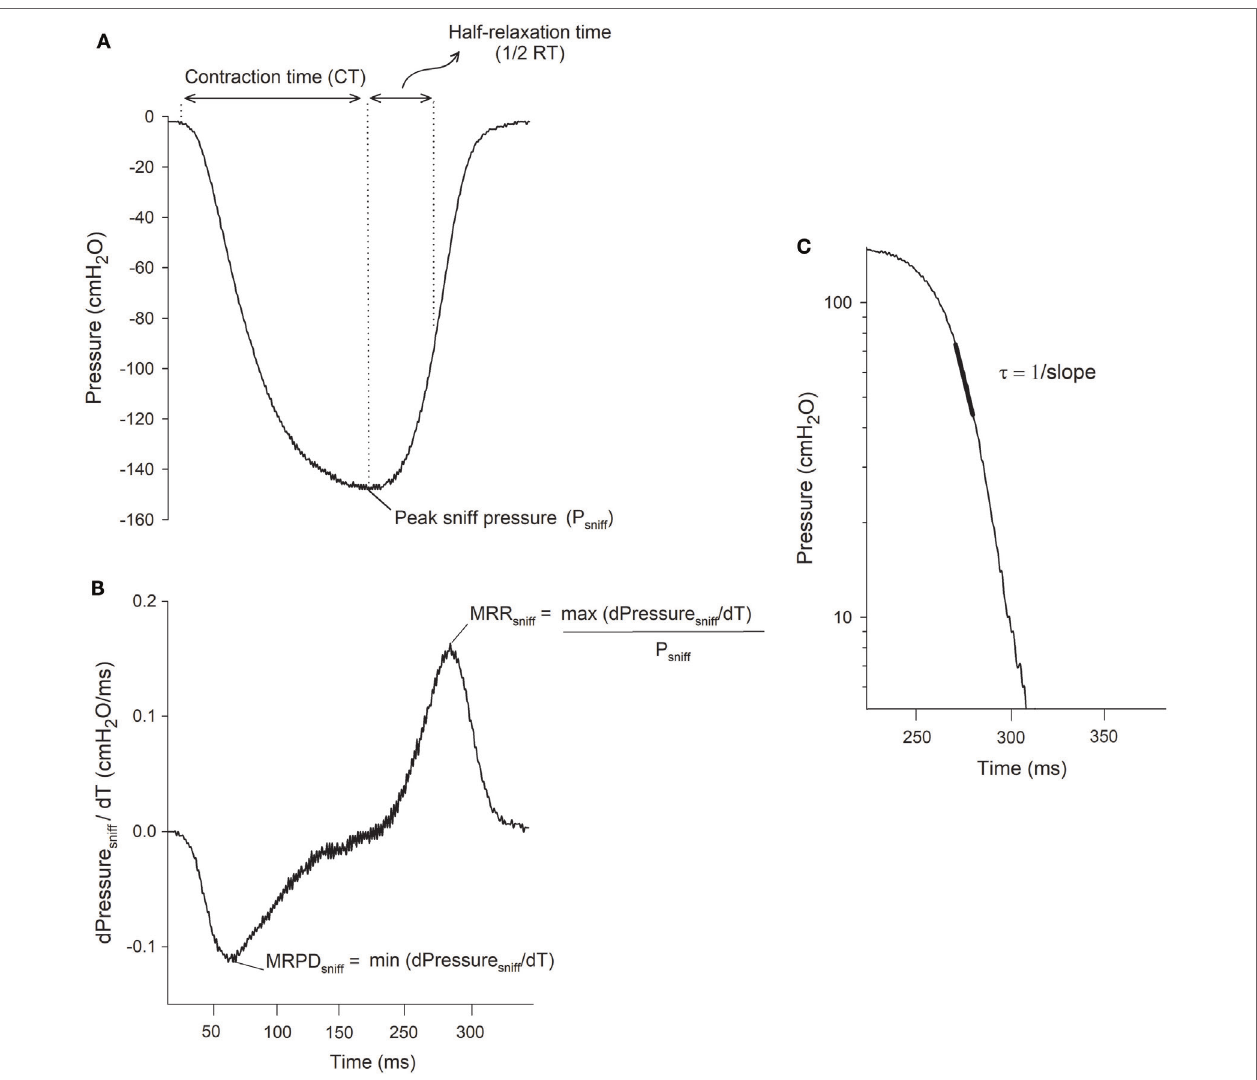
FigUre 1 | Representative tracings of the sniff nasal inspiratory pressure (SNIP) test and its parameters. (a) Tracings of SNIP change; peak sniff pressure (P sniff ); time to reach P sniff , contraction time (CT); and half-time of the relaxation curve (1/2RT). (B) Derivative signal of sniff pressure (dPressure sniff /dT = cmH 2 O/ms); negative peak dP sniff /dT, maximum rate of pressure development (MRPD) positive peak dP sniff /dT normalized by P sniff , maximum relaxation rate (MRR). (c) Decay portion of the sniff pressure plotted on semilog scale vs. time (ms). Linear black portion indicates a single exponential function with a time constant, τ = 1/slope. cmH 2 O, centimeters of